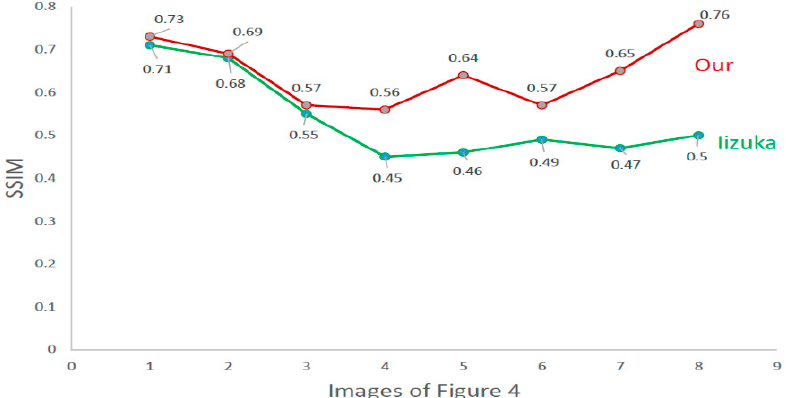
Figure 6. The SSIM result pairs of our method and Iizuka’s method on images of Figure 4.